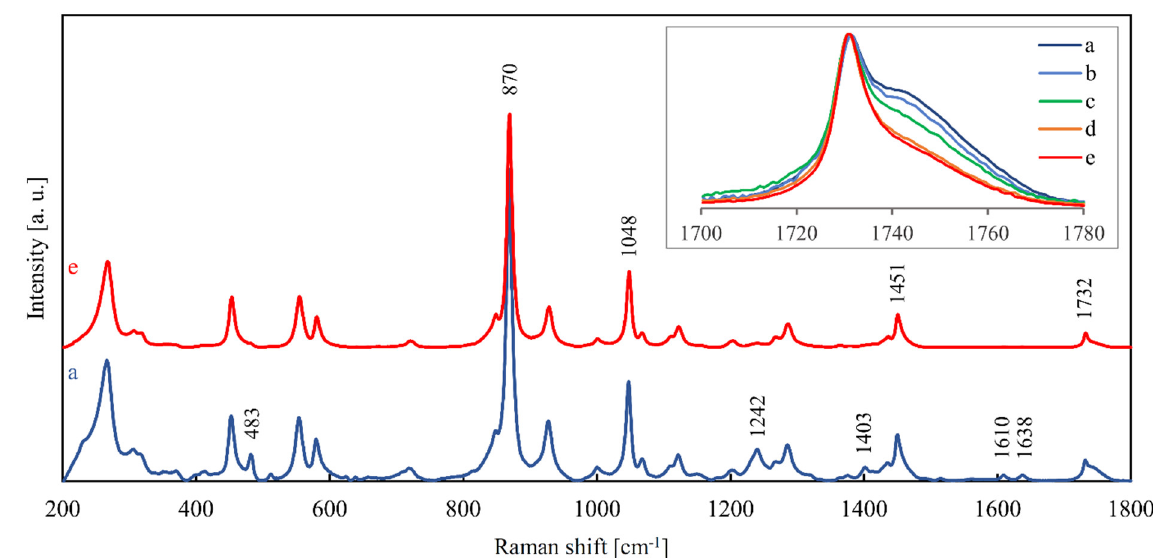
Figure 8. Averaged Raman spectra of the (a) non-degraded stent and (e) 24-weeks-degraded stent after removing the baseline. The inset shows the gradual lessening of the 1732 cm − 1 peak shoulder progressing with the degradation: (a) non-degraded, (b) 4-weeks-degraded, (c) 8-weeks-degraded, (d) 16-weeks-degraded and (e) 24-weeks-degraded stent. Baseline correction was performed in LabSpec 6 software. Table 3. The dependence of the area under the 1732 cm − 1 peak shoulder (between 1736 and 1749 cm − 1 ) on the degradation period.